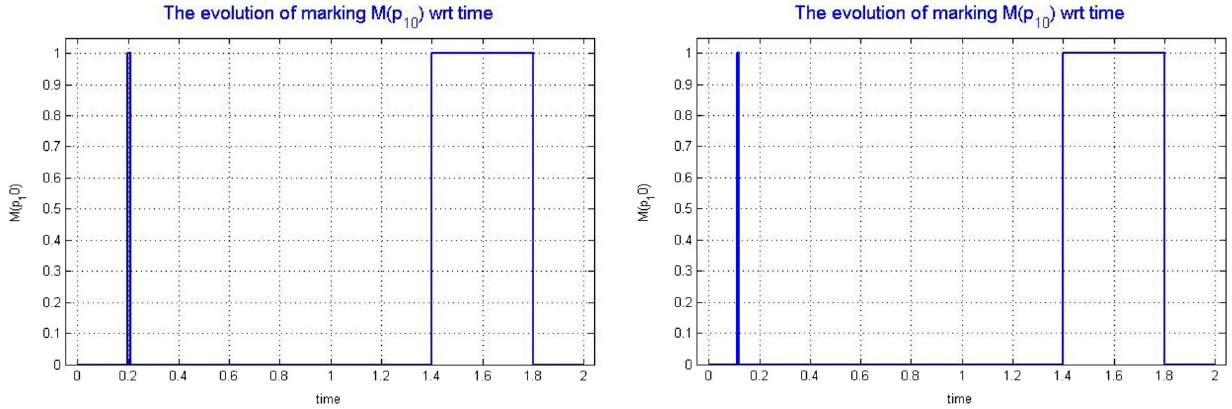
Fig. 13 The courses of marking the place p 10 in the case (i) the left picture, and in the case (ii) the right